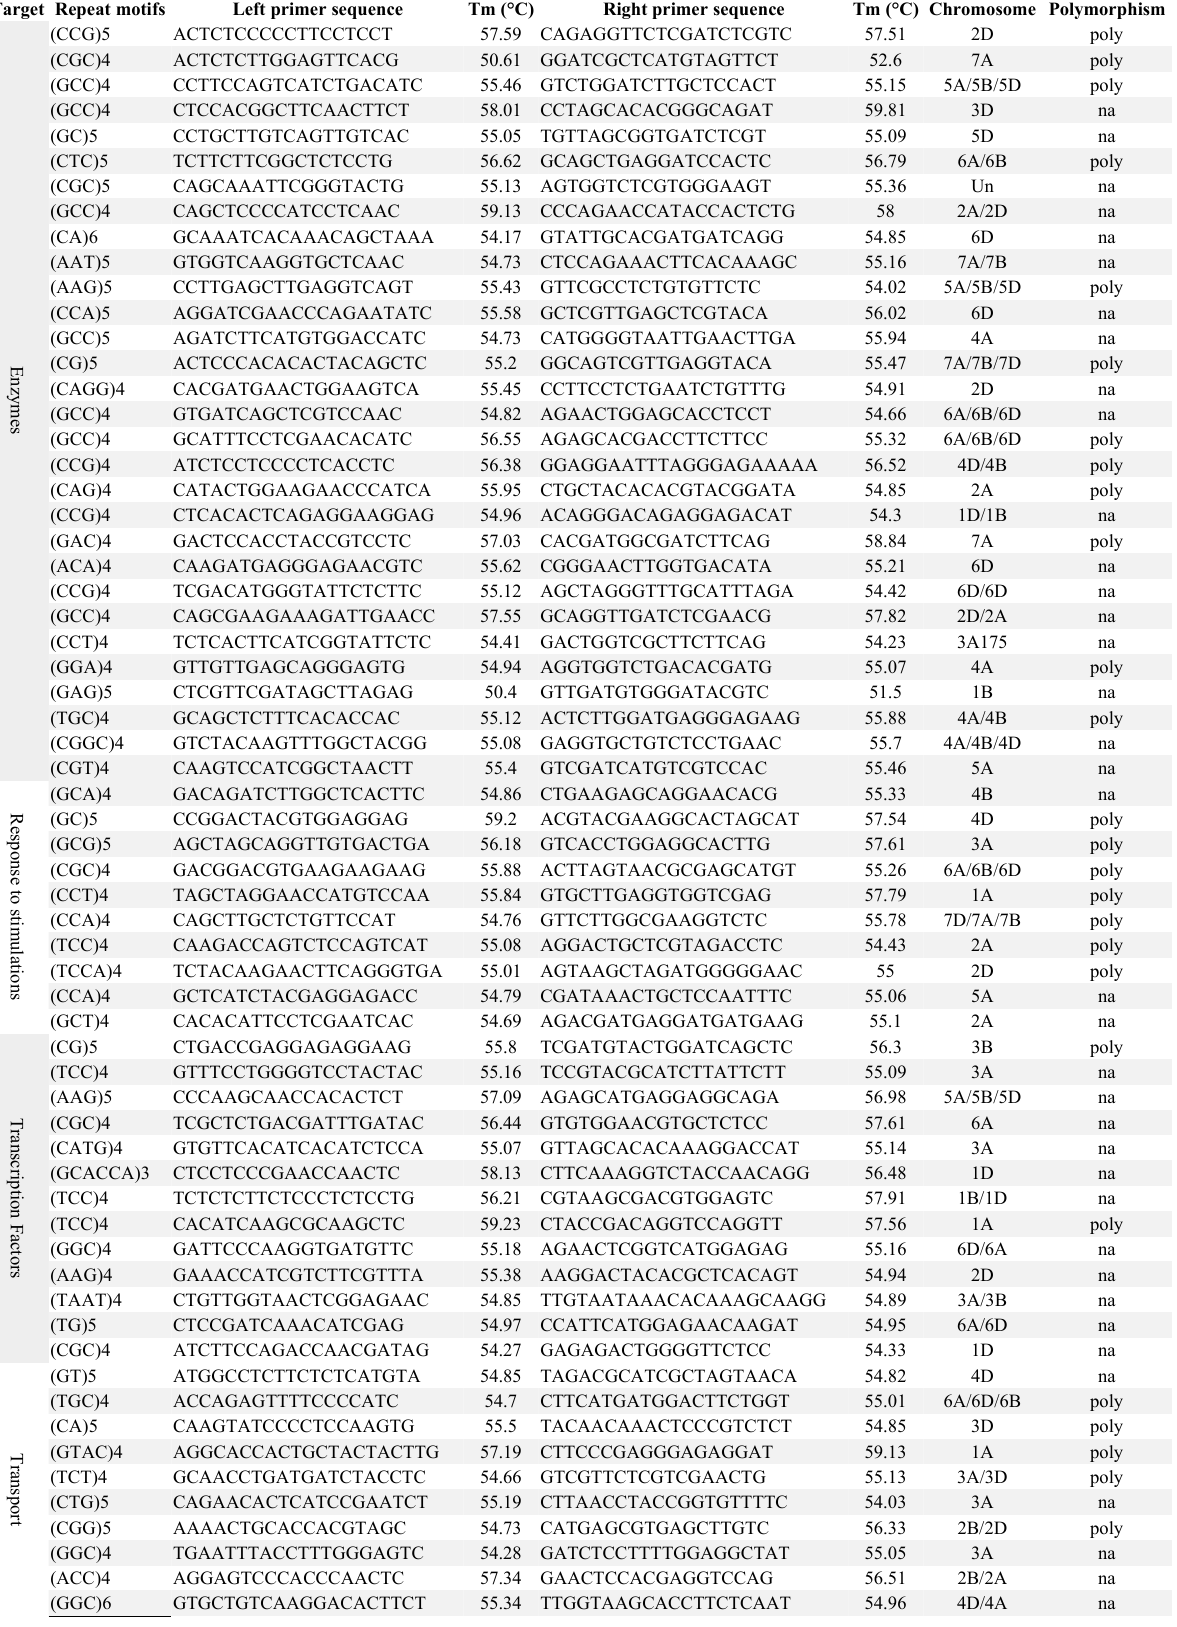
Table 4. Primers designed and polymorphism for enzymes, transport, transcription factors, and proteins responsible to stimulations for SSR-containing